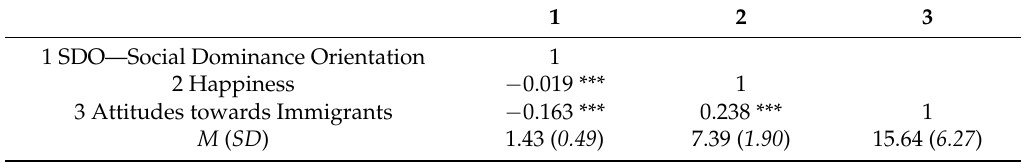
Table 1. Means, standard deviations and intercorrelations among variables investigated in the Study.